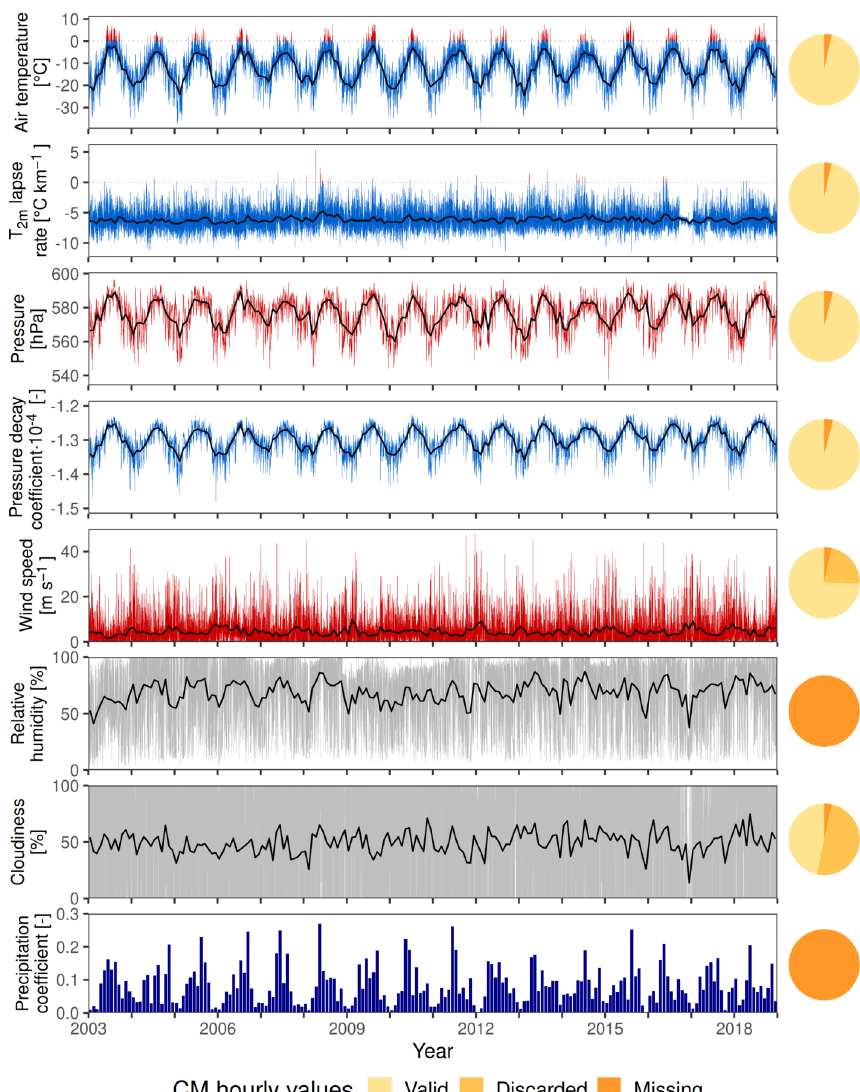
Figure 2. Quality-checked and gap-filled hourly weather series used as model input (reference elevation 4560ma.s.l.). Black lines represent monthly means. For readability, only monthly means are shown for the precipitation down-scaling coefficient (Sect. 3.3). The reduced variability in temperature lapse rates in late 2016 is due to a 4-month data gap, where the series was entirely reconstructed from lower- altitude stations. Pie charts show the contribution of the original CM AWS series to the model input. For cloudiness, the contribution is based on values reconstructed from SW radiation measurements. “Discarded” includes values rejected during quality check as well as nighttime SW radiation measurements; “missing” includes data gaps and parameters not recorded at CM. All such values were replaced with the reconstructed